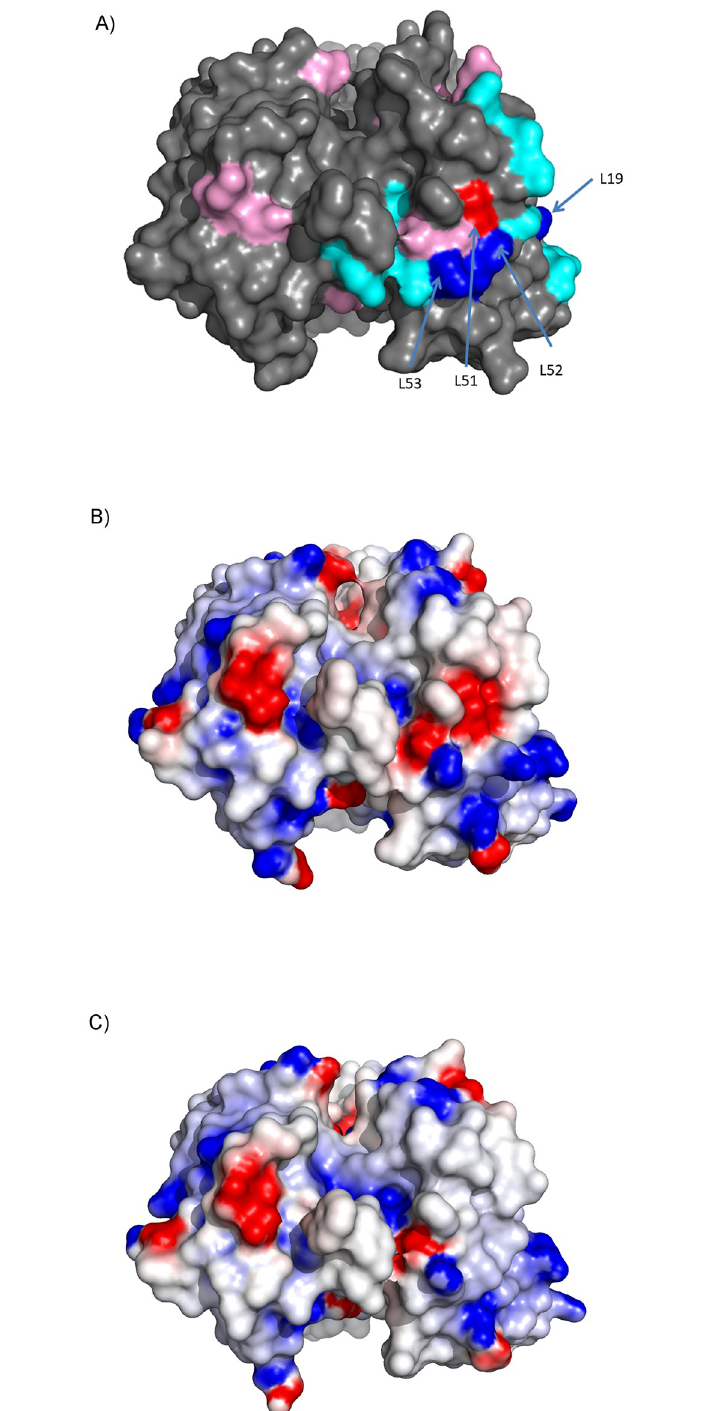
Fig 6. Analysis of the effect of mutations on viscosity. Two sets of mutations were generated and only a few showed an effect at decreasing the overall viscosity of the antibody. In (A), residues that added a positive charge and reduced viscosity are shown in blue, and those that had no effect or increased the viscosity are shown in light blue. Residues that removed a negative charge and reduced the viscosity are shown in red and those that had no effect or increased the viscosity are shown in magenta. The 4 sites that had the largest effect are all clustered together. All sites are annotated with Kabat positions. As comparison to the parental AB-001 and round 2 parental R2-001, (B) shows the electrostatic potential energy surface of clone R2-006 which had reduced viscosity with maintained activity and (C) shows the electrostatic potential energy surface of R2-020 which has reduced viscosity with 3X loss of activity.